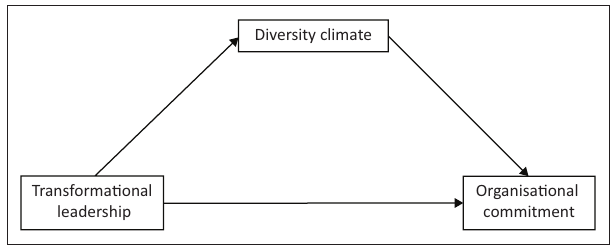
FIG URE 1: Proposed model, transformational leadership, diversity climate and organisational